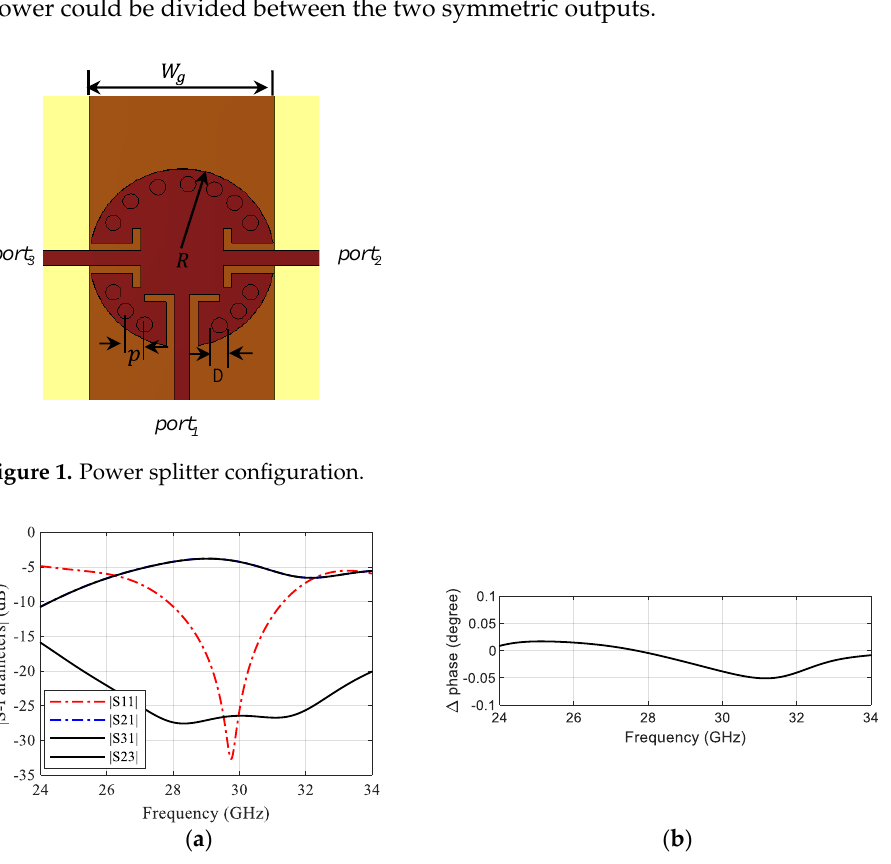
Figure 2. Power splitter performance. ( a ) S-parameters of the circular SIC power splitter. ( b ) Phase